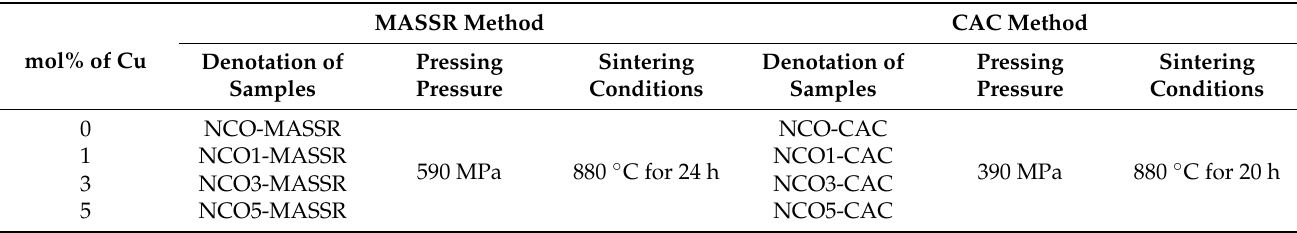
Table 1. Preparation of ceramic samples from precursor powders by MASSR and CAC